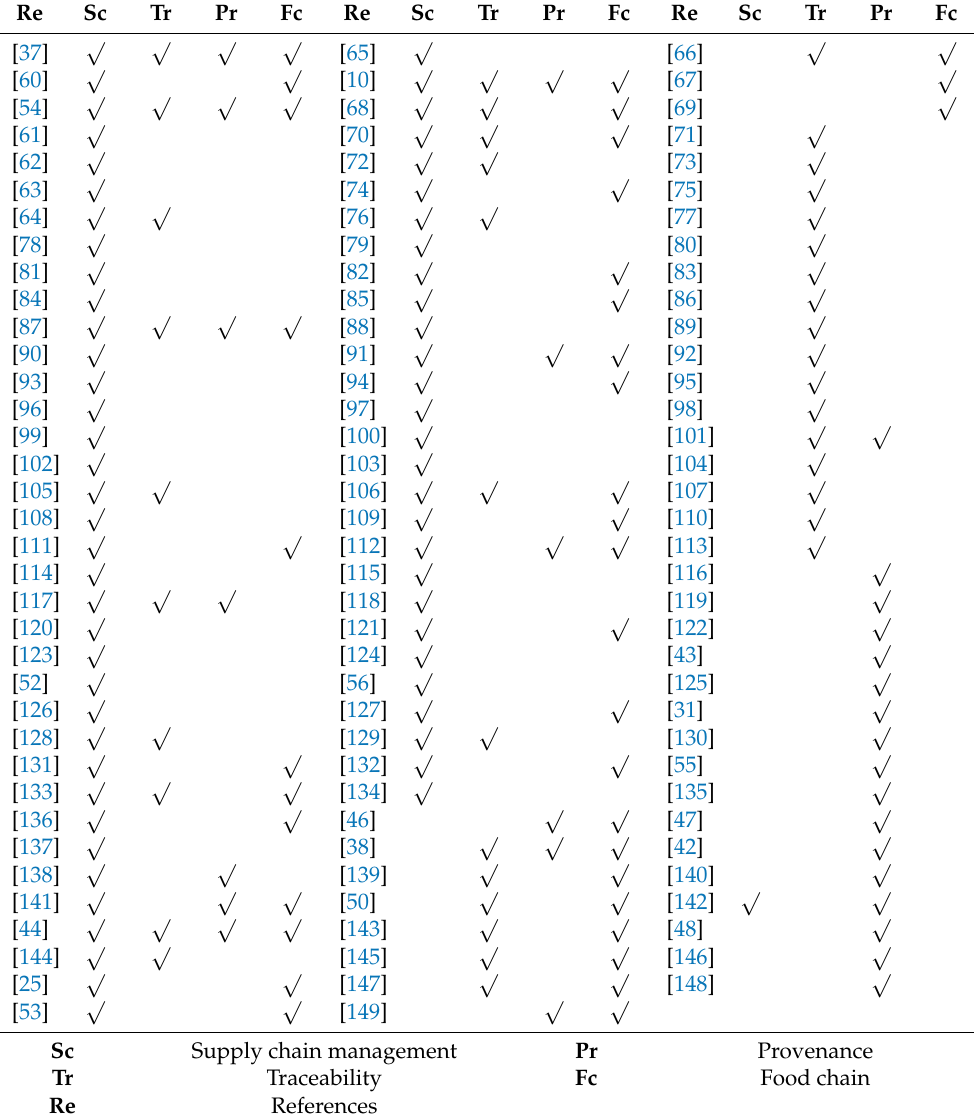
Table 5. Application of blockchain in agriculture for the supply